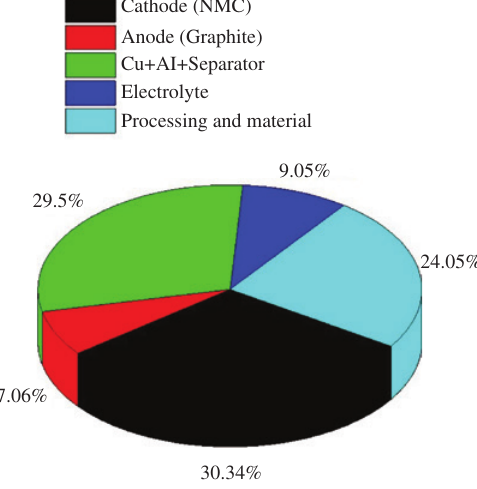
Figure 21: Cost contributions for state-of-the-art NMC lithium-ion cell manufacturing (cell manufacturing cost 272 $/kWh; data were extracted from